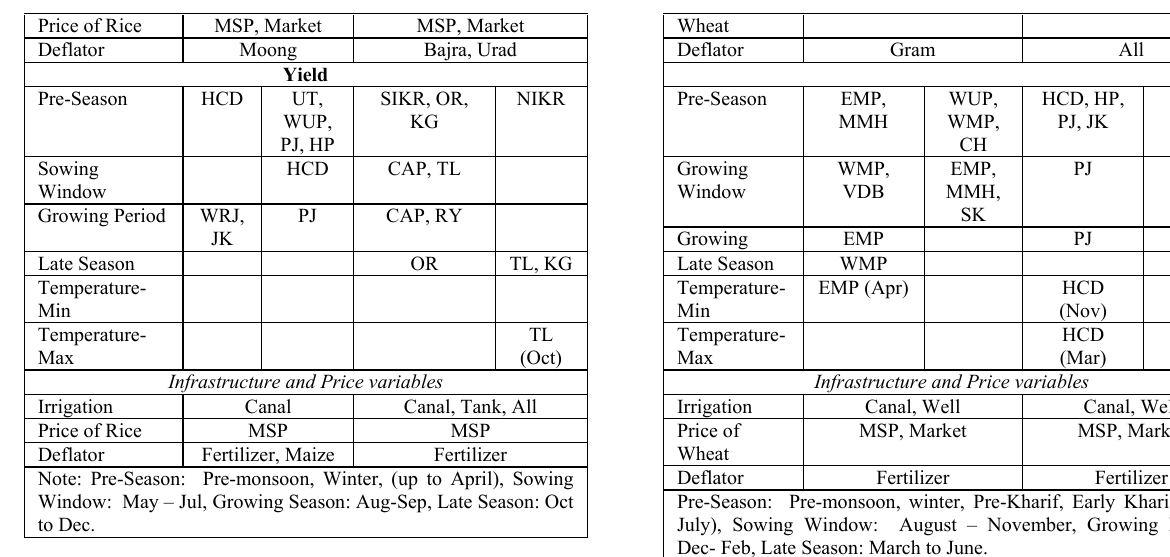
Table A3a: Variables that matter based on estimated regression equation: Wheat Rabi Uttar Pradesh